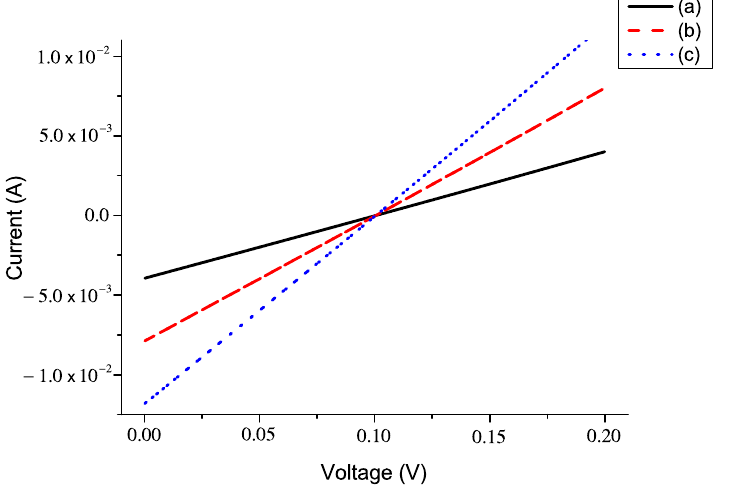
Figure 1. Parametric curves I ( V ) for an electrolytic cell with identical electrodes having the same adsorption properties for positive and negative ions, when the screening parameter is b = 0.04, in the absence of the desorption phenomenon (desorption time tending to ∞ ). The adsorption coefficients are 10 − 6 m/s (a), 2 × 10 − 6 m/s (b), and 3 × 10 − 6 m/s